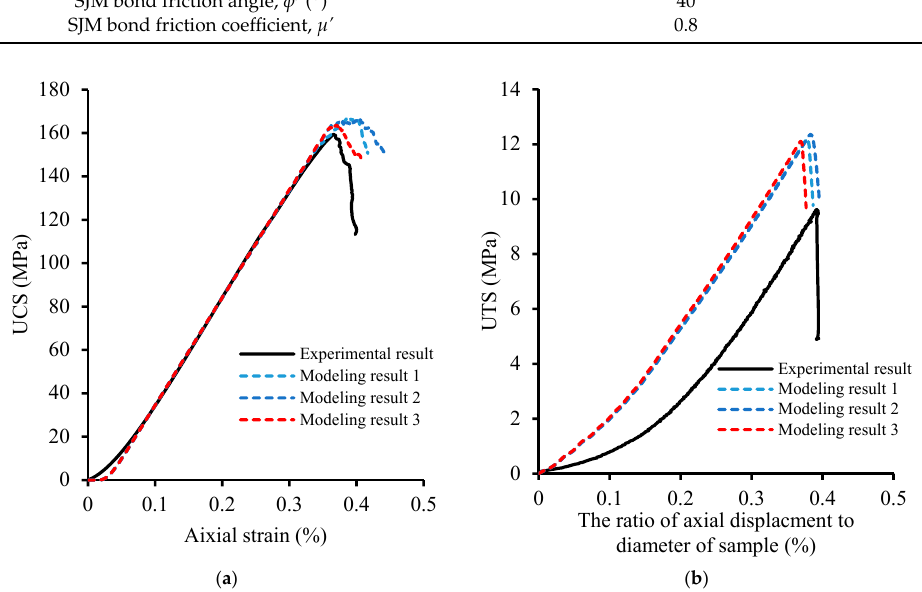
Figure 9. Microscale parameter calibration for Alasha granite by modeling of UCS and UTS tests. ( a ) The stress–strain curves under UCS testing; ( b ) The curves of axial stress vs. axial deformation under UTS testing.